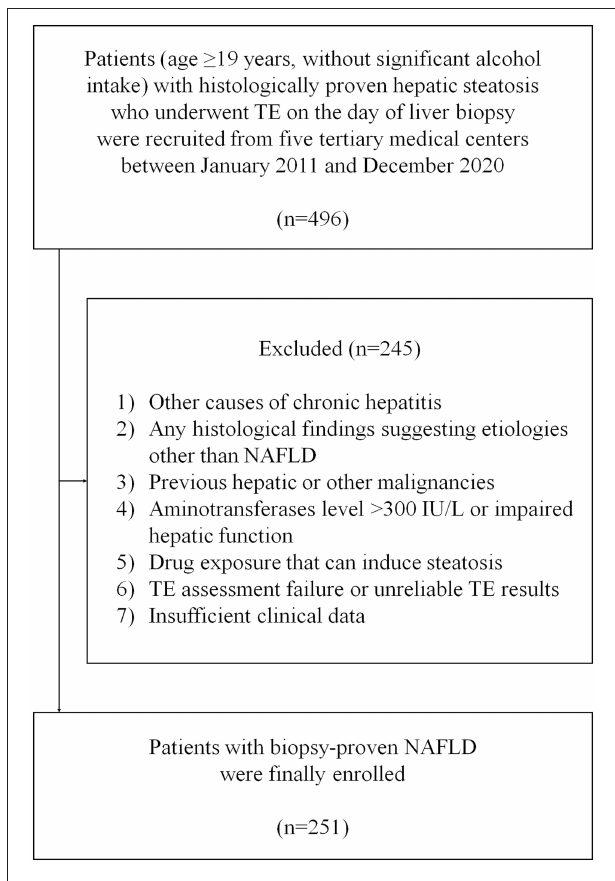
FIGURE 1 | Flowchart of the study. NAFLD, non-alcoholic fatty liver disease; NASH, non-alcoholic steatohepatitis; TE, transient